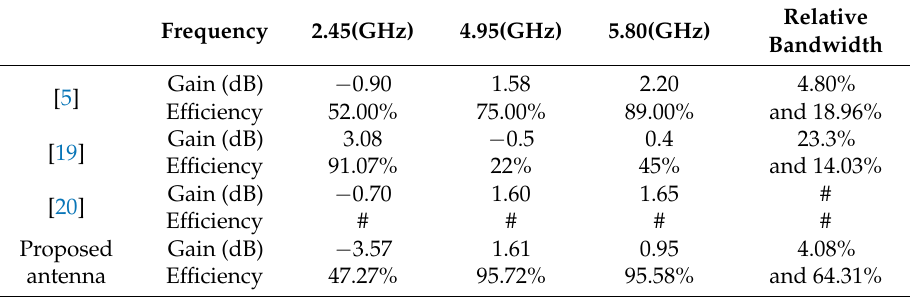
Table 5. Comparison between the proposed and some existing antennas.